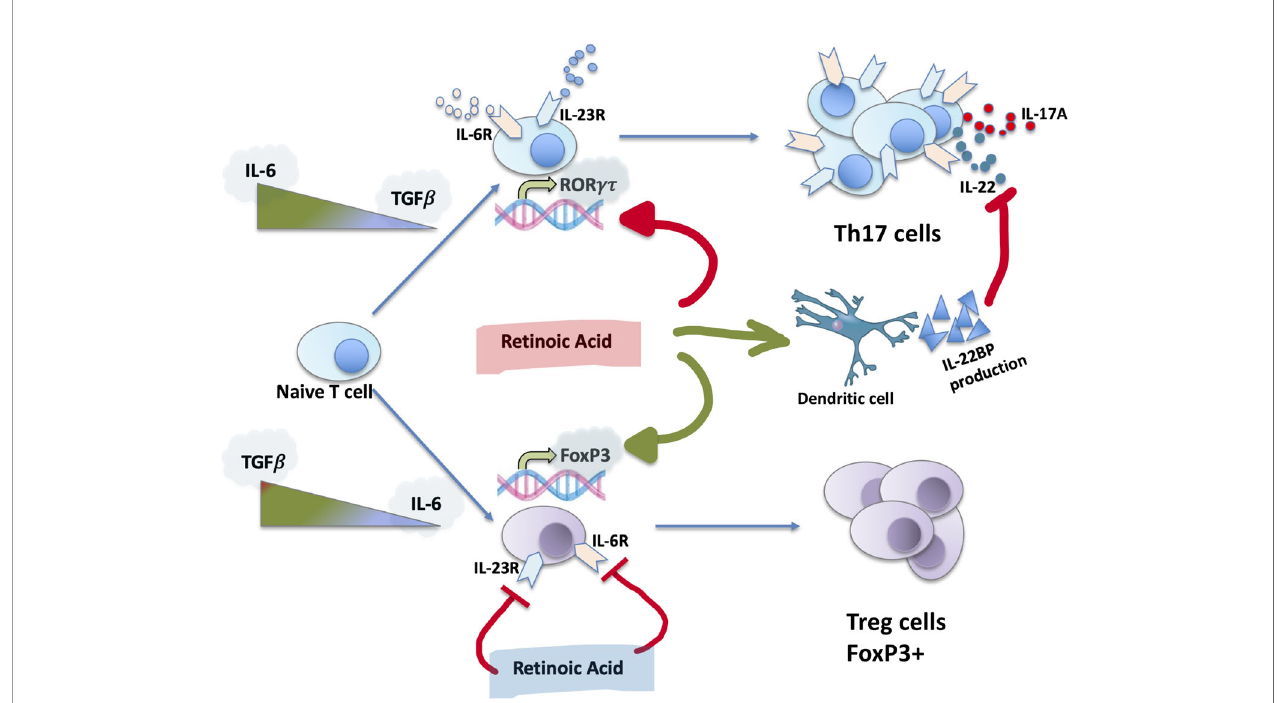
FIGURE 2 | Th17 differentiation, role of RA. RA, the active metabolite of vitamin A, is capable to inhibit ROR gt expression, promoting the development of iTregs and FoxP3 expression. RA inhibits the expression of IL-23 and IL-6 receptors, stimulates IL-22BP synthesis by dendritic